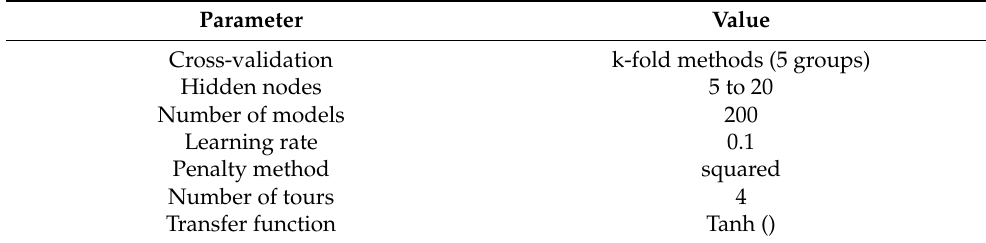
Table 6. Independent variables and their levels.